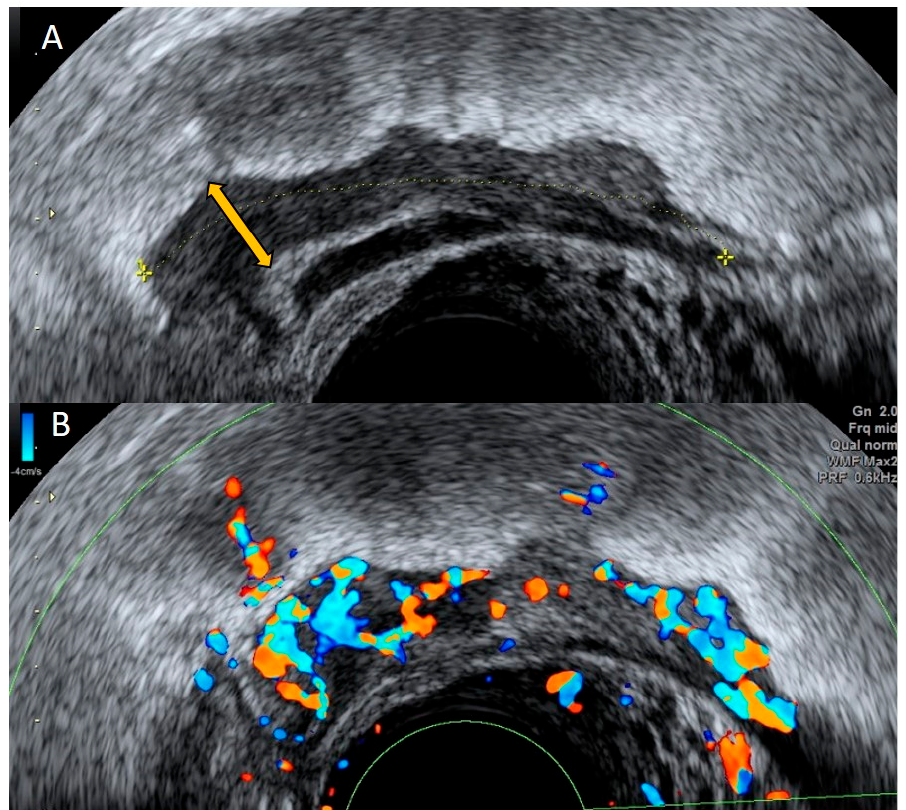
Figure 9. Transvaginal grayscale ( A ) and color Doppler image ( B ) of a patient with colonic carcinoma. Note the focal thickening of the colonic wall (double arrow) and the abundant vascularization in color Doppler study.